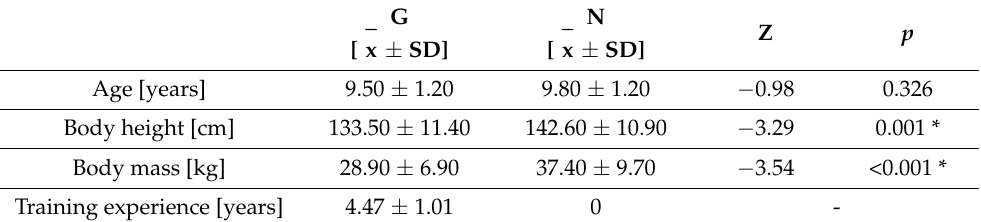
Table 1. Characteristics of the female artistic gymnasts ( n = 30) and non-training girls ( n = 30).